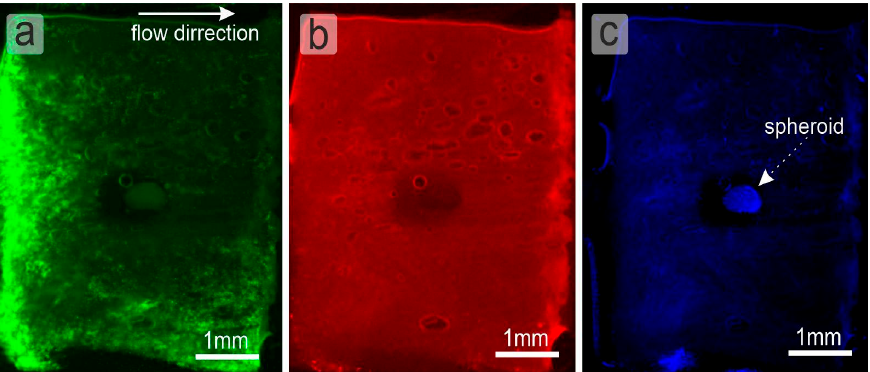
Figure 3. Fluorescence microphotograph of the LNOC during experiment. ( a ) Green fluorescence are Jurkat cells (Calcein AM). ( b ) Red fluorescence are polymer capsules (Cy5). ( c ) Blue fluorescence is 4T1 cellular spheroid (Hoechst). Flow direction is shown in the ( a ) by the white arrow (from left to right